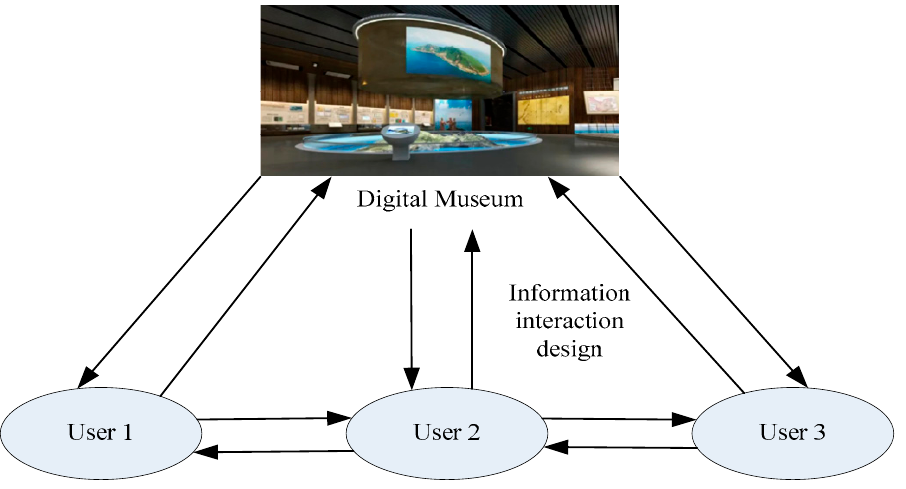
Figure 4. Model diagram of interactive design of digital museum.